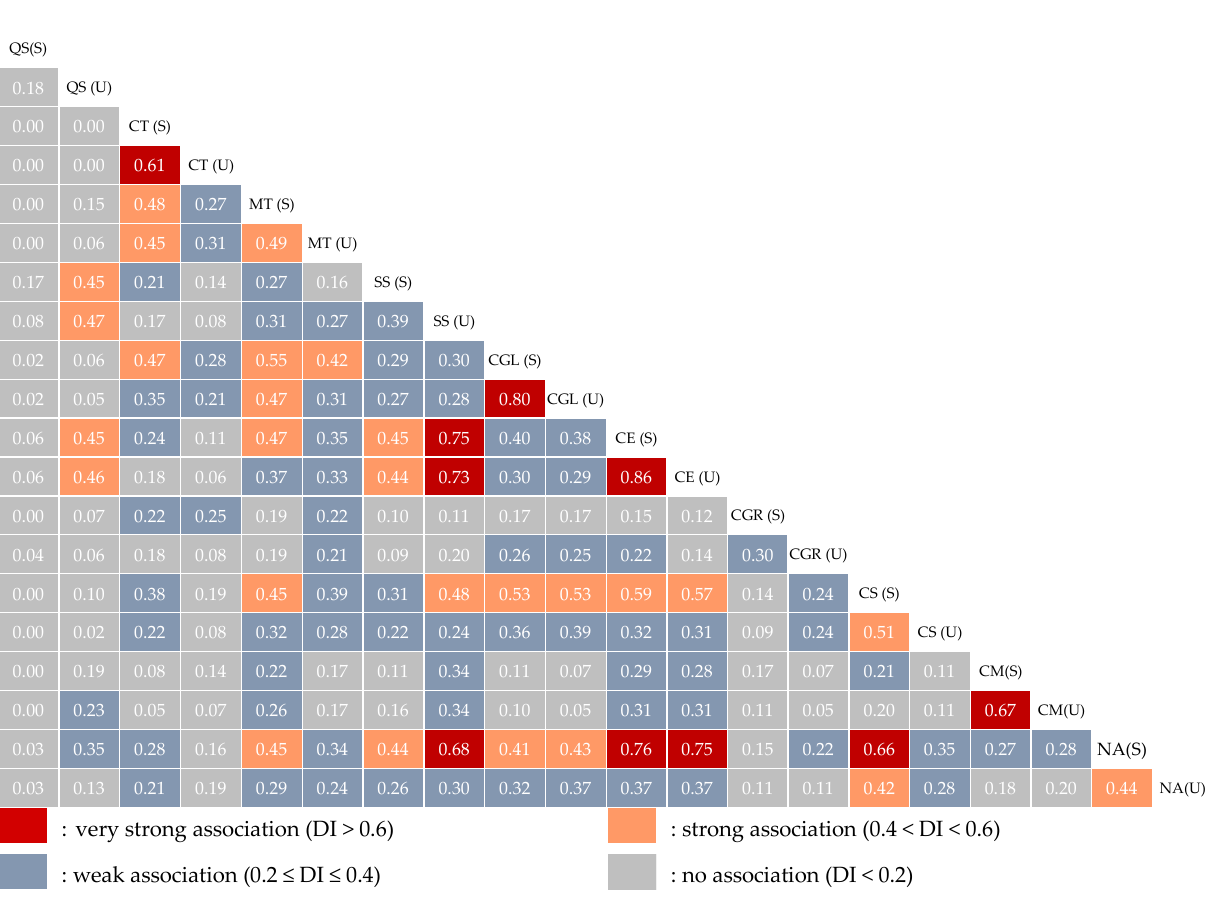
Figure 4. Correlation matrix of the Dice index (DI) results of the dominant species in the old-growth forest.